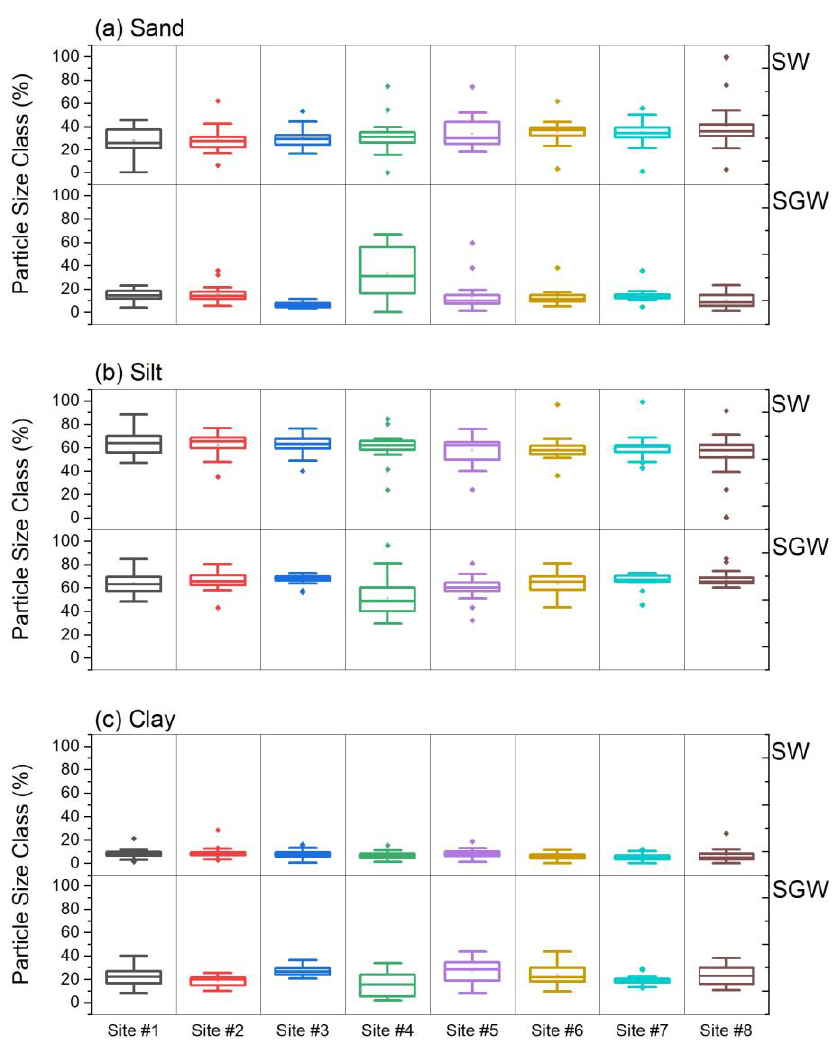
Figure 4. Box and whisker plots of stream water (SW) and shallow groundwater (SGW) suspended sediment particle size classes [i.e., sand, silt, and clay (%)] during the study period (January 2020 − December 2021) for eight monitoring sites in Moore’s Run Watershed, Wardensville, WV, USA; box delineates 25th and 75th percentiles; line denotes median; open circle shows mean; whiskers delineate the range (i.e., 1.5 times the interquartile range); the filled circle indicates potential outliers.